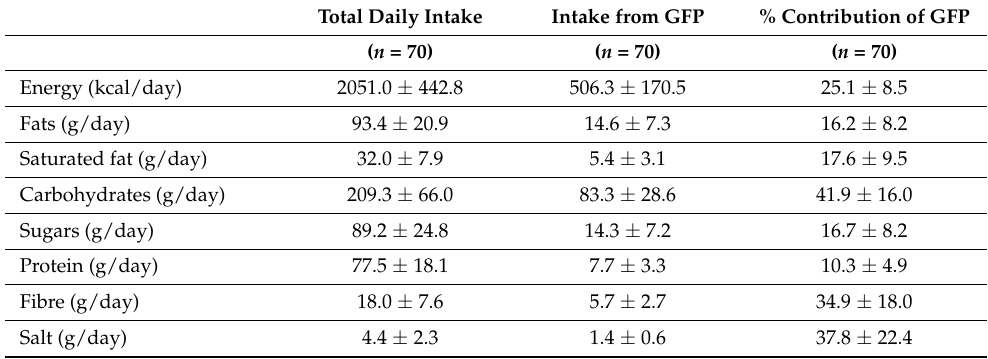
Table 2. Contribution of gluten-free products, both processed and homemade, to the diet (energy and nutrient content) of Spanish children and adolescents, both sexes, with celiac